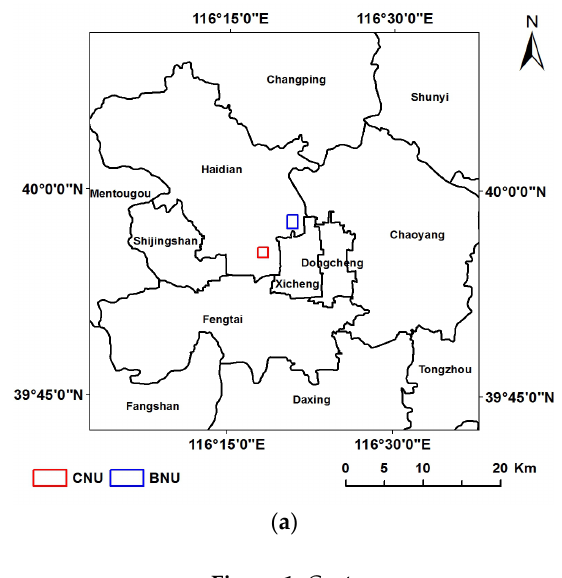
Figure 1. Cont. Figure 1.